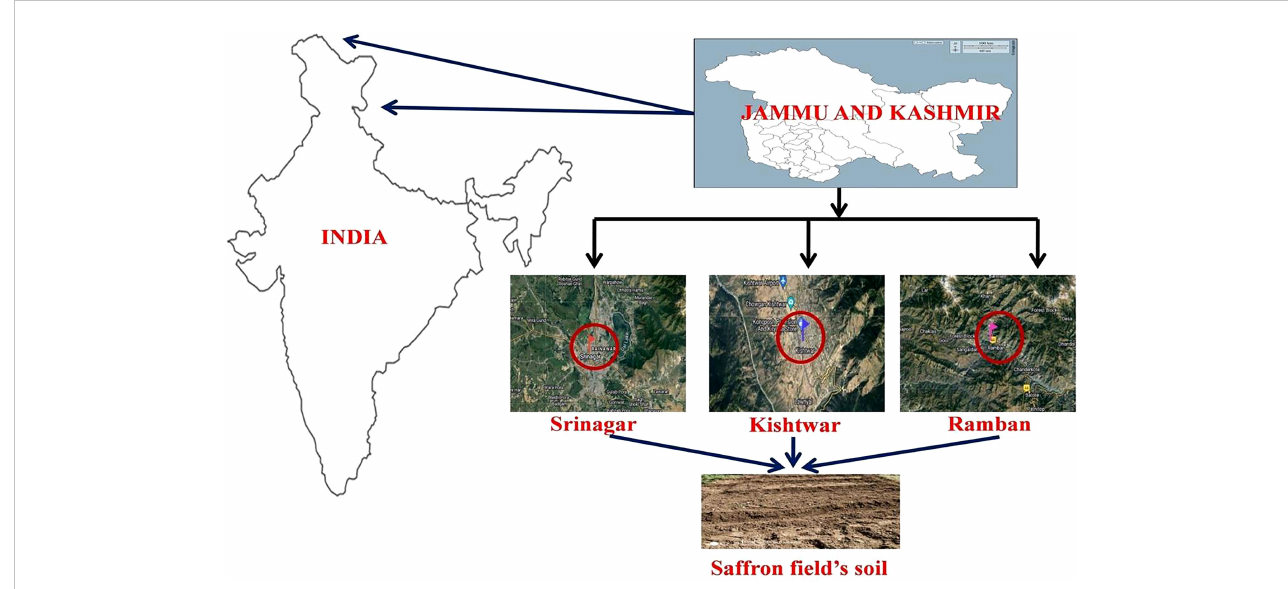
FIGURE 1 Picture representing the geographical regions (Srinagar, Kishtwar, and Ramban) of saffron fi elds from where soil samples were